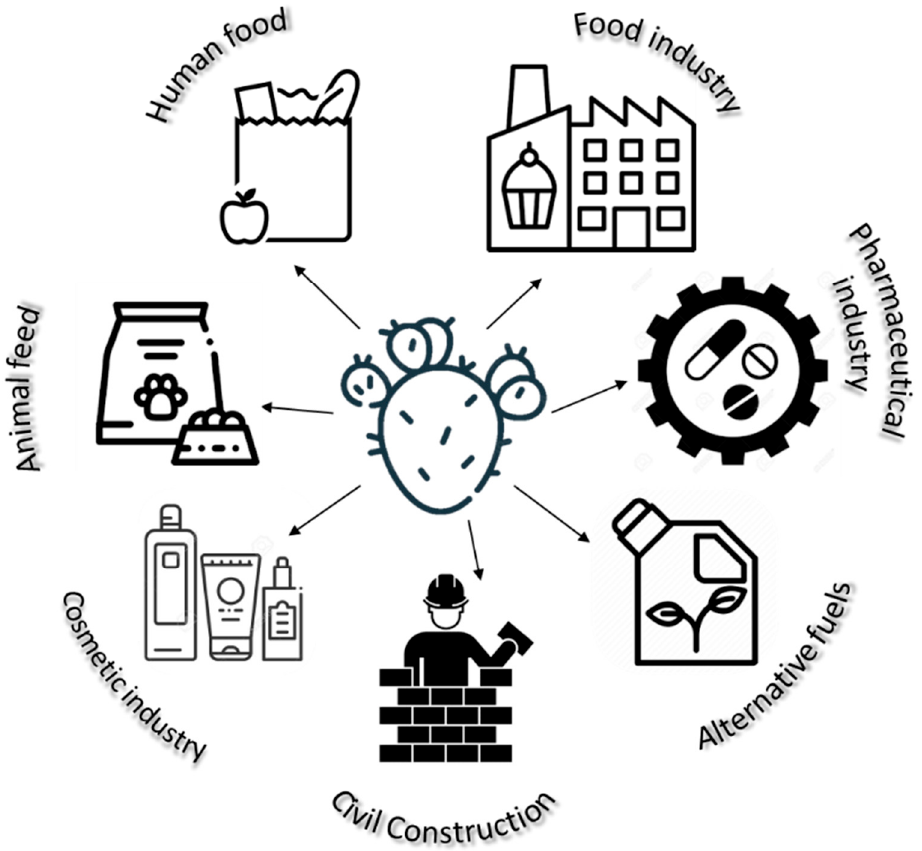
Figure 4. Applications of OFI fruits and cladodes [2,5,17,18].